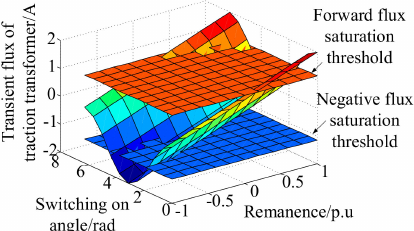
Figure 7. Transient flux of the traction transformer a ff ected by remanence and switching